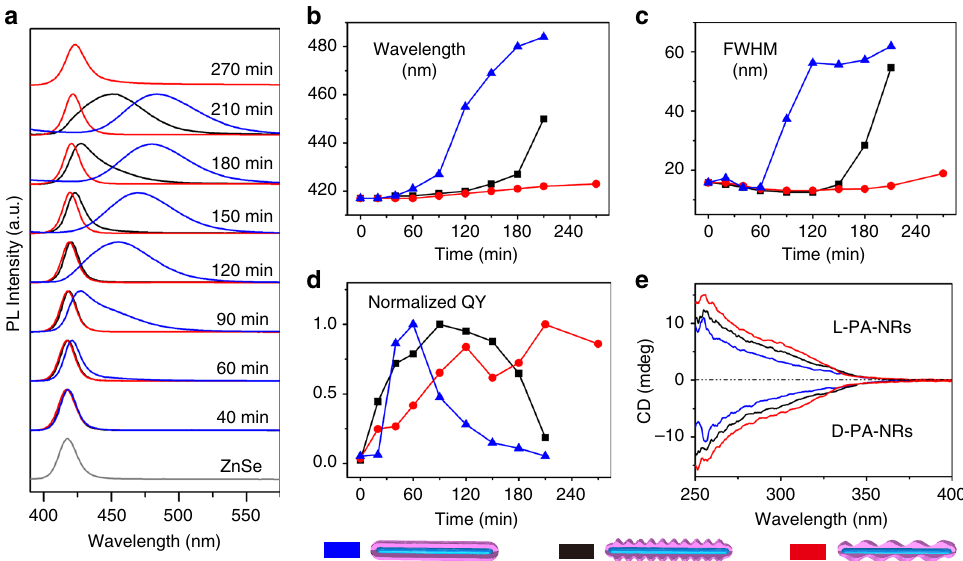
Fig. 4 Optical properties of ZnSe/ZnS core/shell nanorods with different shell morphologies. Comparing spectra were obtained for similar growth conditions aside from precursor reactivity at different reaction times (blue — fl at-shell, black — islands-shell, red — helical-shell). a Emission spectra. b Emission peak wavelength. c FWHM of emission spectra. d Normalized emission quantum yield. The normalization is performed based on the respective highest values. e CD spectra after chiral ligand exchange. The core/shell nanorods samples were transferred to water by using L- and